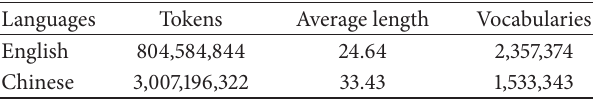
Table 8: Statistics of English & Chinese corpora.